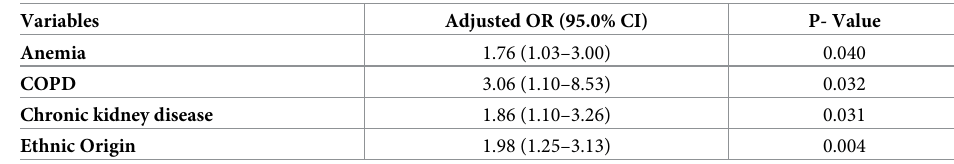
Table 6. Multivariate logistic regression analysis of death due to COVID-19